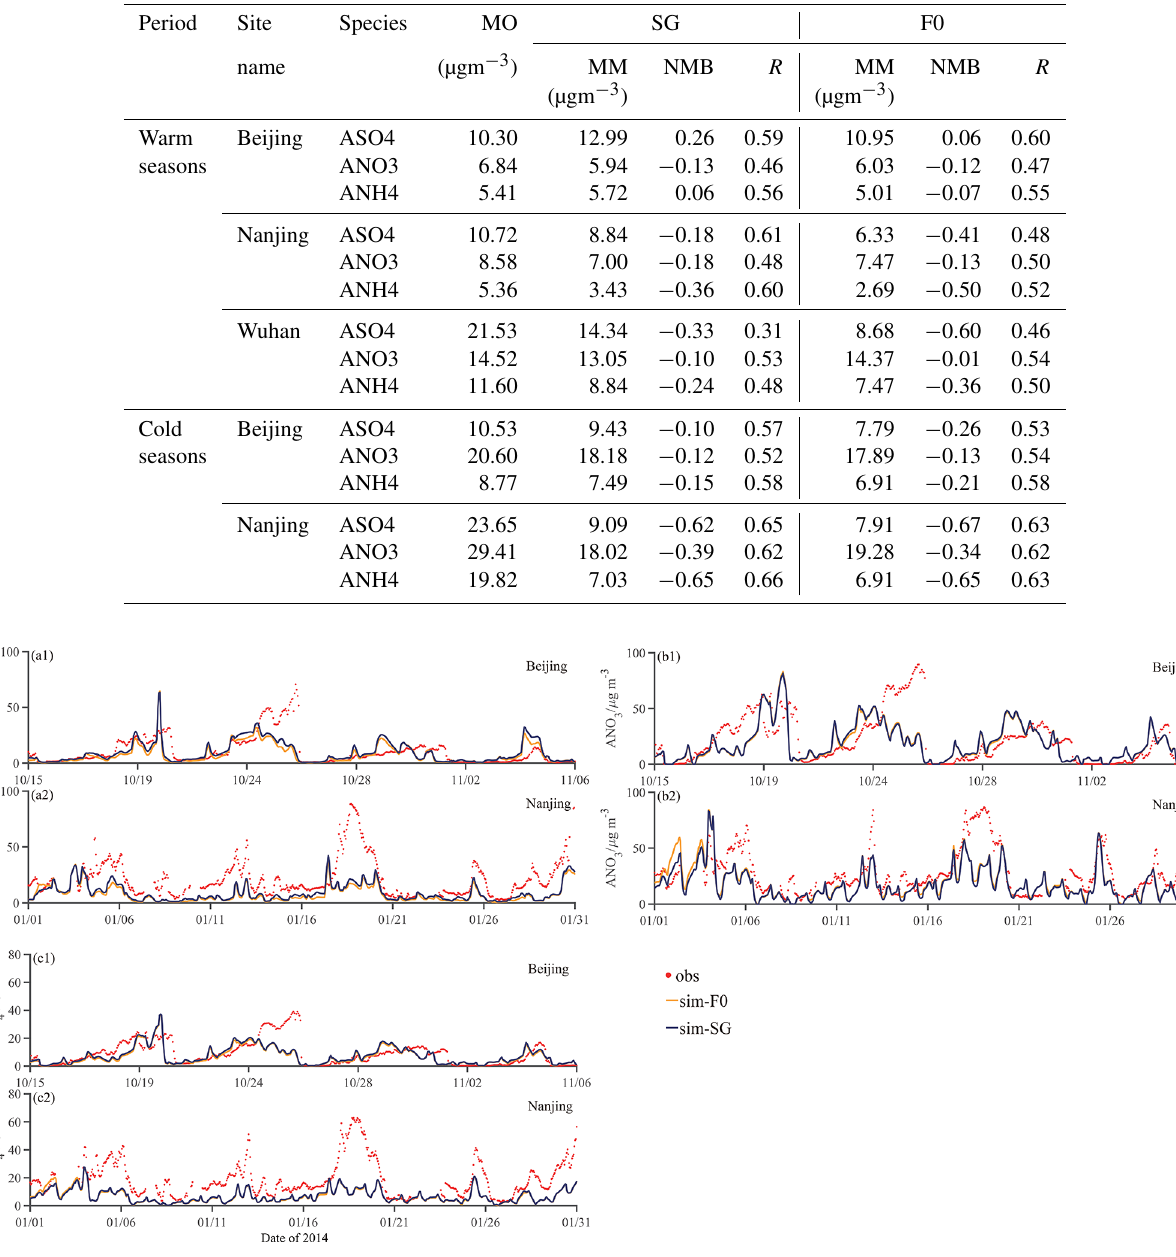
night due to very low OH concentration in the plume. Com- pared with observations, the sub-grid scheme significantly optimized the overestimation of particle number concentra- tion in small size bins (Fig. 9b). Specifically, considering the diurnal variation in nucleation process reduced the positive bias by more than 3 times in nucleation mode and by about